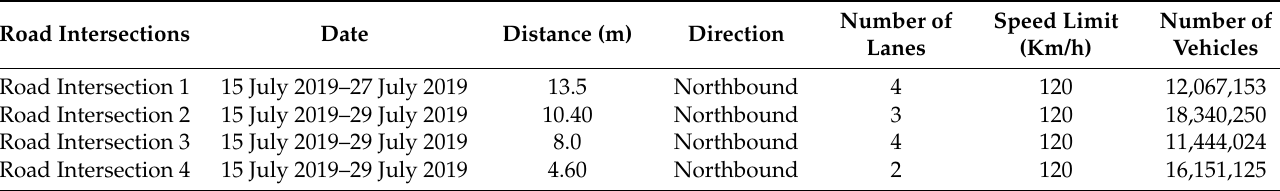
Table 1. Features of the Signalized Road